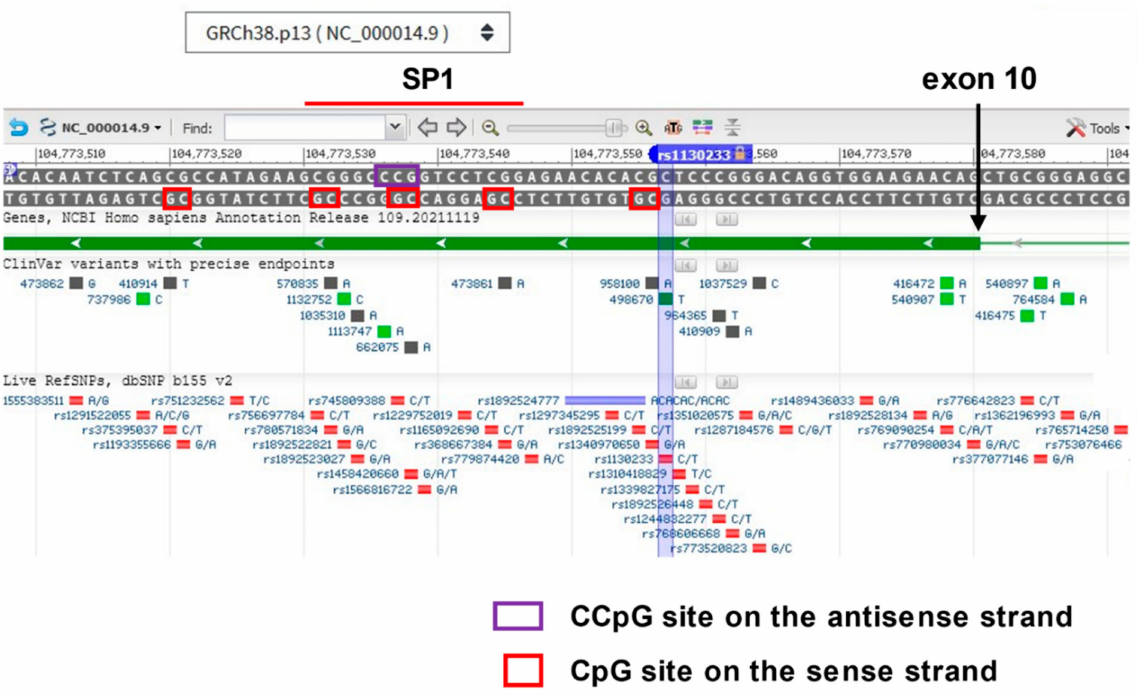
Figure 4. Screenshot of exon 10 of the AKT1 gene on the NCBI gene map for chromosome 14, intended to illustrate the power of NCBI data available, including the panoply of SNPs shown below, most very rare. Note the reverse orientation of the gene. Hovering a cursor over exon 10 (shown in dark green) will allow access to the FASTA nucleotide and protein sequence for the entire gene. Location of rs1130233 is shown relative to downstream CpG sites identified by Blest- Blest-Hopley et al. [117] to be differentially methylated in correlation with degree of THC-induced regional human brain activation in response to a fearful cue. The chromosomal location given in their paper for two sites found to be most significantly differentially methylated, chr14: 104,773,527–104,773,522, does not correspond to any two adjacent CpG sites separated by 5 bp. However, just upstream are two methylation sites separated by 5 bp, are part of a binding site for the expression-enhancing transcription factor SP1, according to the in silico analysis tool Alibaba2. Binding of SP1 within an exon is known to occur for other genes [128–130]. SP1 binding is generally not affected by methylation, except when